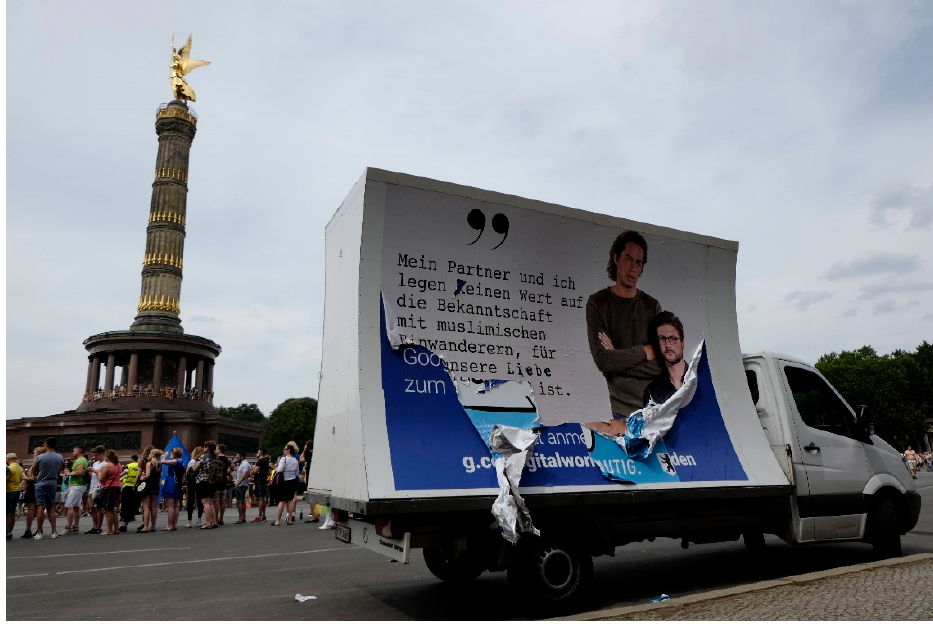
Figure 2. AfD poster at the CSD parade 2016, Berlin, credit: imago images/Snapshot. Figure 1 uses bold, graphic text superimposed on a beach scene featuring three female bodies in scanty bikinis. At the level of visual content (1), the visual style of